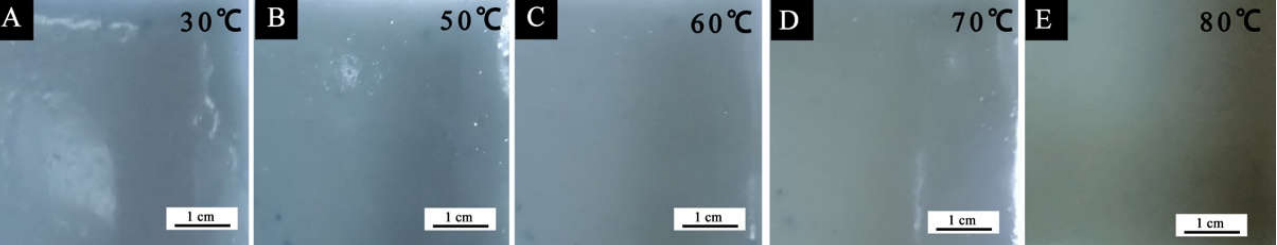
Table 3. Photochromic chromaticity value of the film under different finishing sequences.